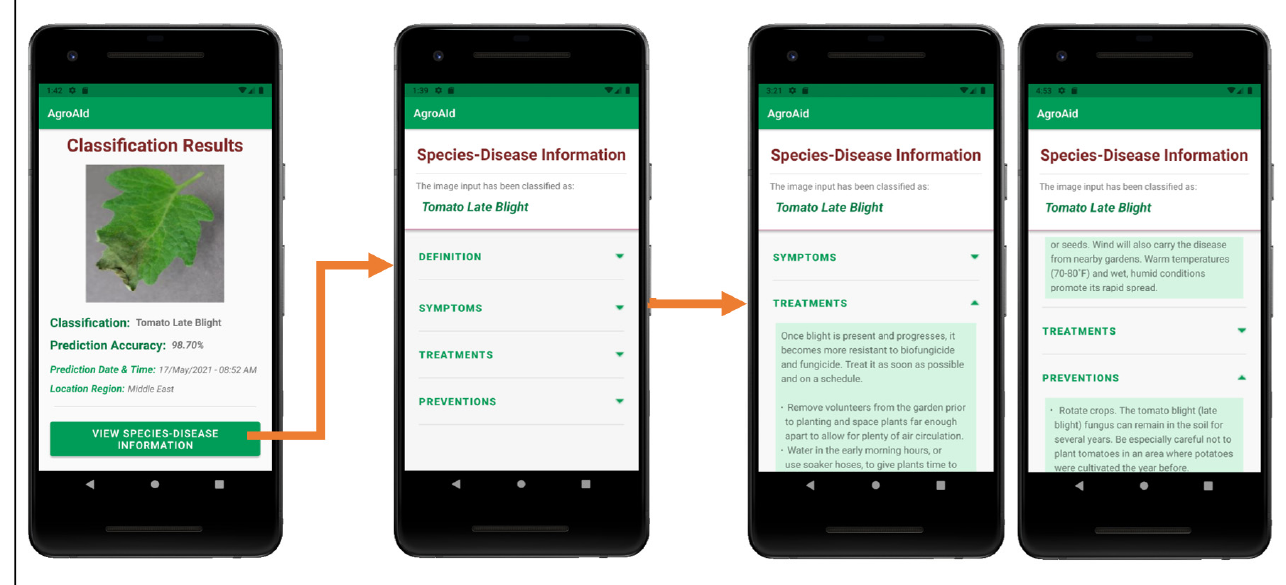
Figure 27. Example of the process of viewing the plant care support information provided for a [ species–disease ] combination identified in a classification result.